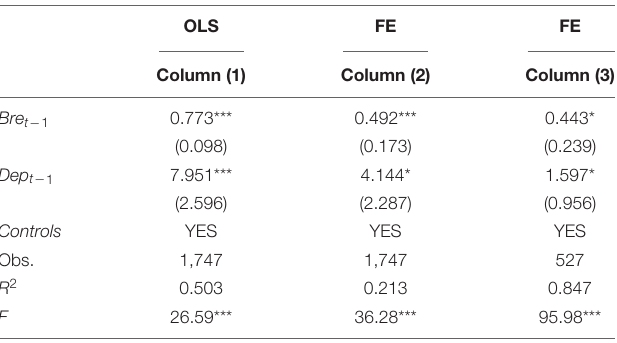
TABLE 3 | Robustness test